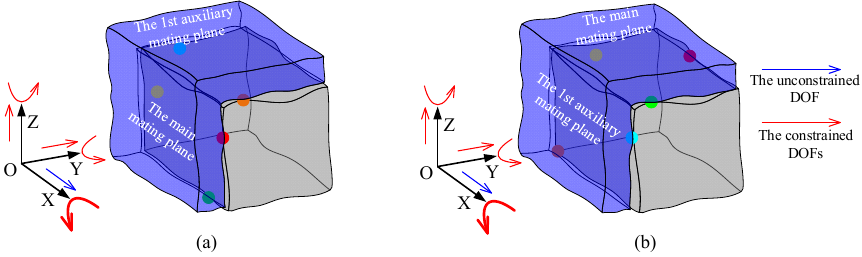
Figure 4. Possible cases of the main and auxiliary mating planes of the assembly with two mating planes. DOF, degree of freedom. ( a ) Case 1 of the main and auxiliary ones among all the mating planes, ( b ) Case 2 of the main and auxiliary ones among all the mating planes.